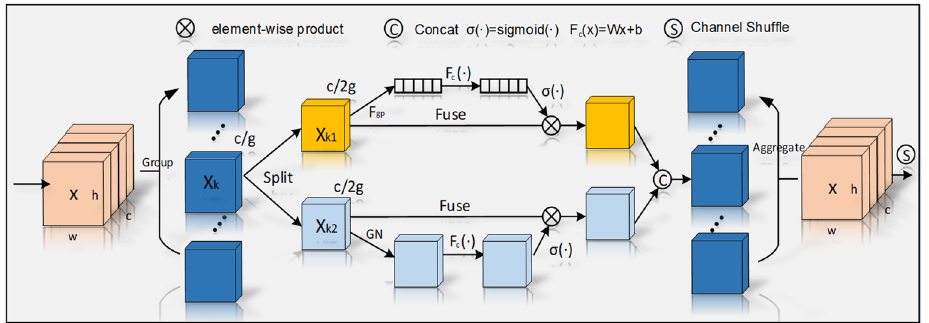
Figure 8. SA network architecture diagram.